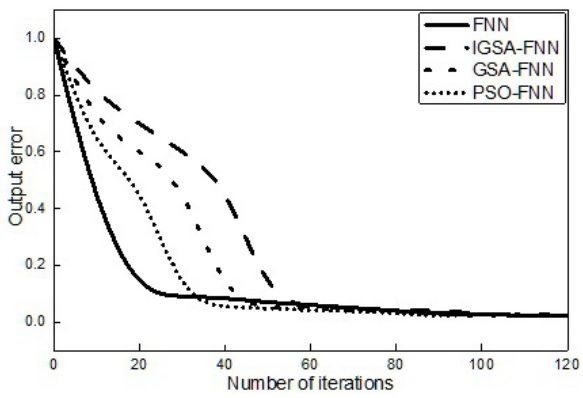
Fig. 4 Convergence comparison of each optimisation